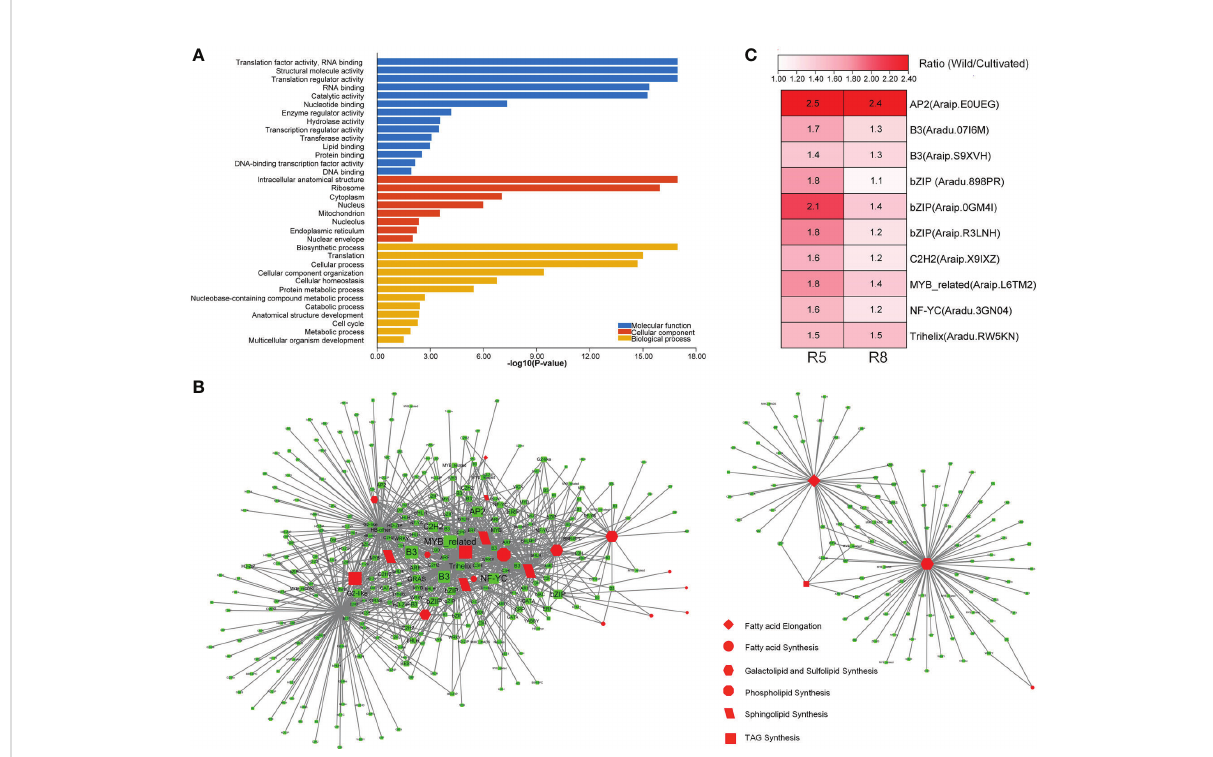
FIGURE 4 Identi fi cation of co-expression genes with DEGs involved in lipid metabolism. (A) GO enrichment analysis of co-expression genes. GO terms with P -value <0.05 were listed in the y-axis. (B) Network of co-expression TFs with lipid metabolic DEGs. (C) Differential expression of top 10 co-expression TFs between wild and cultivated peanuts. Ratio (Wild/Cultivated) represented fold change of FPKM values between wild and cultivated peanut. FPKM fragments per kilobase of transcript per million mapped